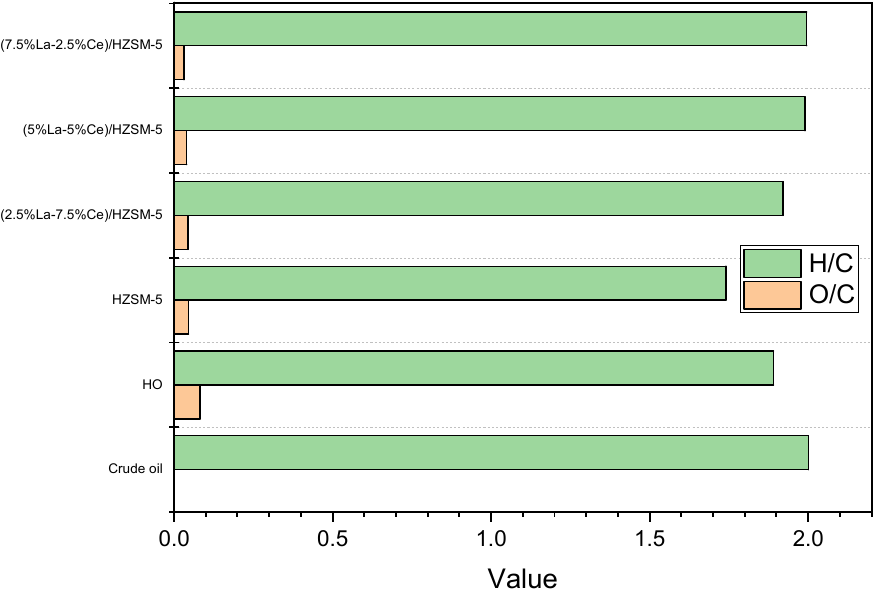
Figure 16. van Krevelen diagram of the liquid products produced by catalytic deoxygenation of the algal HO for HZSM-5 and Lanthanum-Cerium-modified zeolite catalysts. In this study, the products from the parent HZSM-5 had the lowest yield of hydrocar- bons (21.833%) and the lowest conversion (94.589%) of the algal HO. This could be because of the number of other compounds with oxygen. For example, the fact that the catalytic deoxygenation of algal HO makes fewer hydrocarbons than the parent HZSM-5 catalyst might be because it makes more alcohols, esters, aldehydes, ketones, and ethers (refer to Table